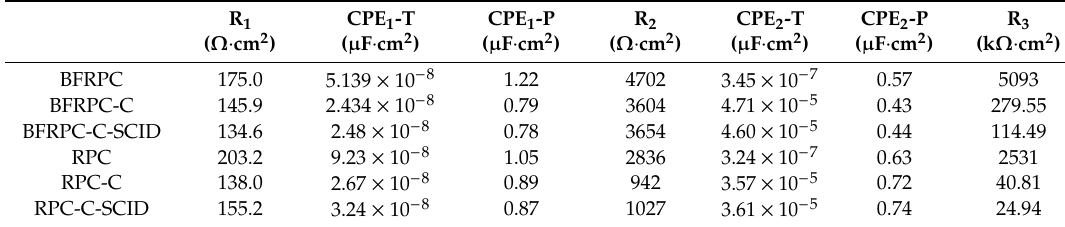
Table 5. Electrochemical parameters of EIS test.